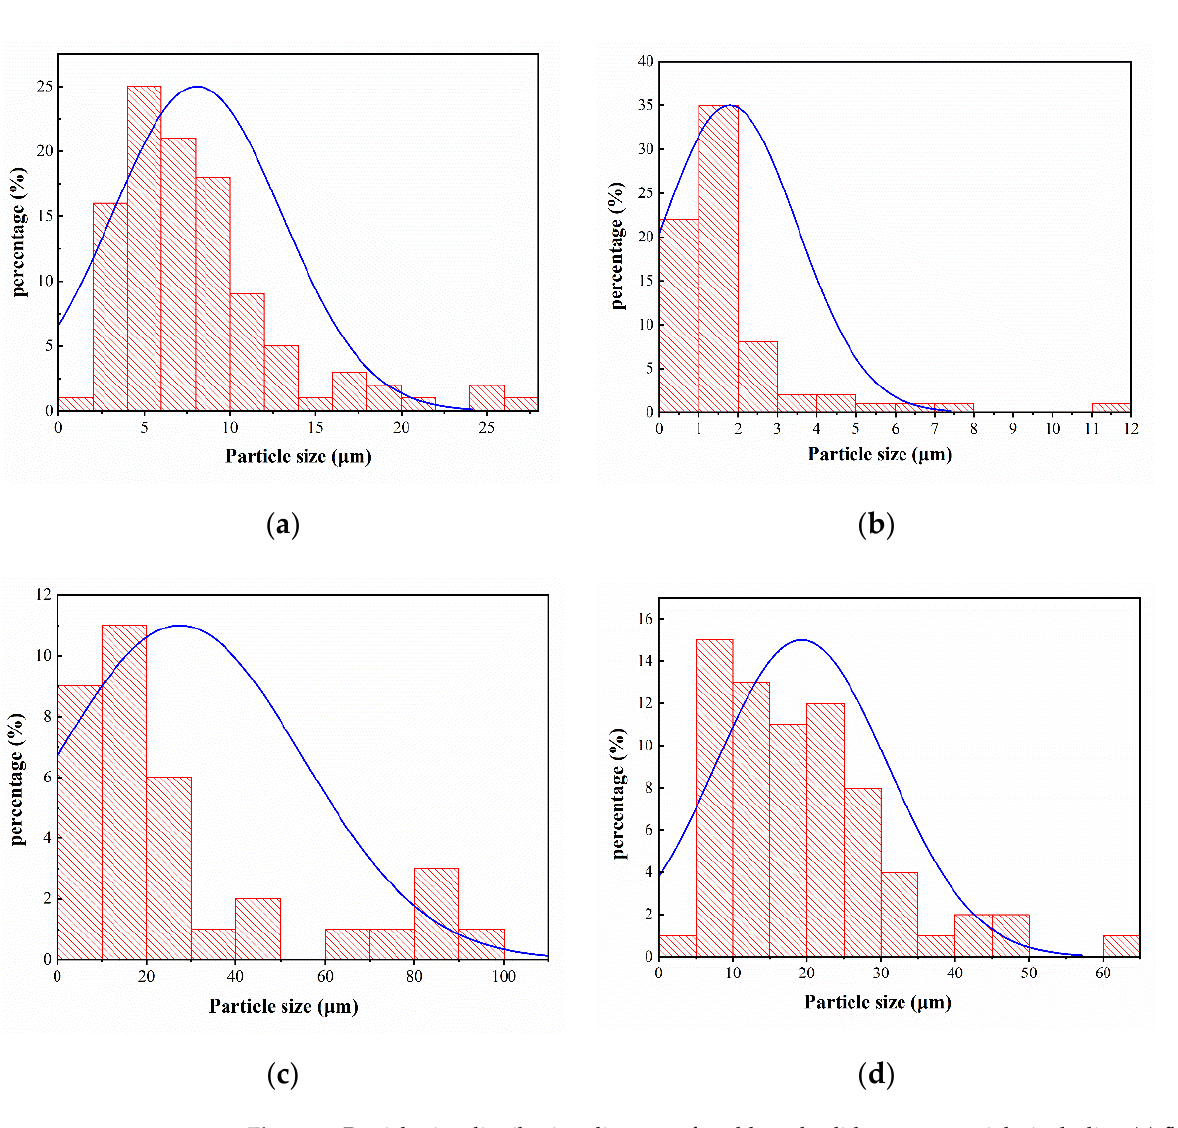
Figure 7. Particle size distribution diagram of coal-based solid waste materials, including ( a ) fly ash, ( b ) gasification slag, ( c ) bottom slag, ( d ) desulfurized gypsum. According to the GB \ T50080-2016 national standard [31], the quality of coal gangue is fixed, and according to the design plan of various coal-based solid waste materials, the test water and cement were weighed in turn, we used a cement paste mixer to fully stir the mixture, and casted the mixed cementitious material into a standard cube mold of 70.7 × 70.7 × 70.7 mm. We used the vibrating table to reduce the air and gap in the mold, then used the scraper to level the mold surface, and placed the leveled mold indoors, as shown in Figure 8. At the same time, part of the mixed cementitious material was added into the plexiglass container with a height of about 120 mm to ensure that the height of the measured filling surface was consistent and then it was sealed with fresh-keeping film. After standing indoors for 24 h, the bleeding rate was measured and recorded. The 48 sets of experimental data obtained were recorded. Three standard cube molds of 70.7 × 70.7 × 70.7 mm were made in each group of experiments, and a total of 144 standard cube molds were made in the experiment. After indoor curing for 12 h, we took the sample out of the mold and placed it in a constant temperature and humidity curing box at 20 ◦ C and humidity of 90 ± 5% until it was taken out during the test, as shown in Figure